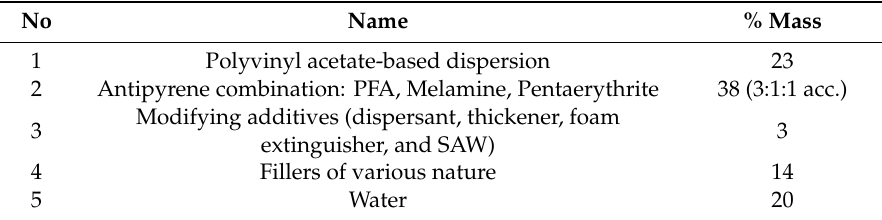
Table 2. Generalized structure of the tested fireproof paint formulation.